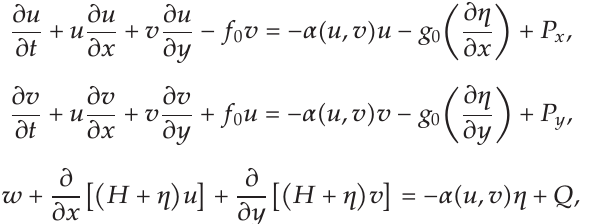
Sin (cid:2) t (cid:3) for q (cid:5) 1 . q